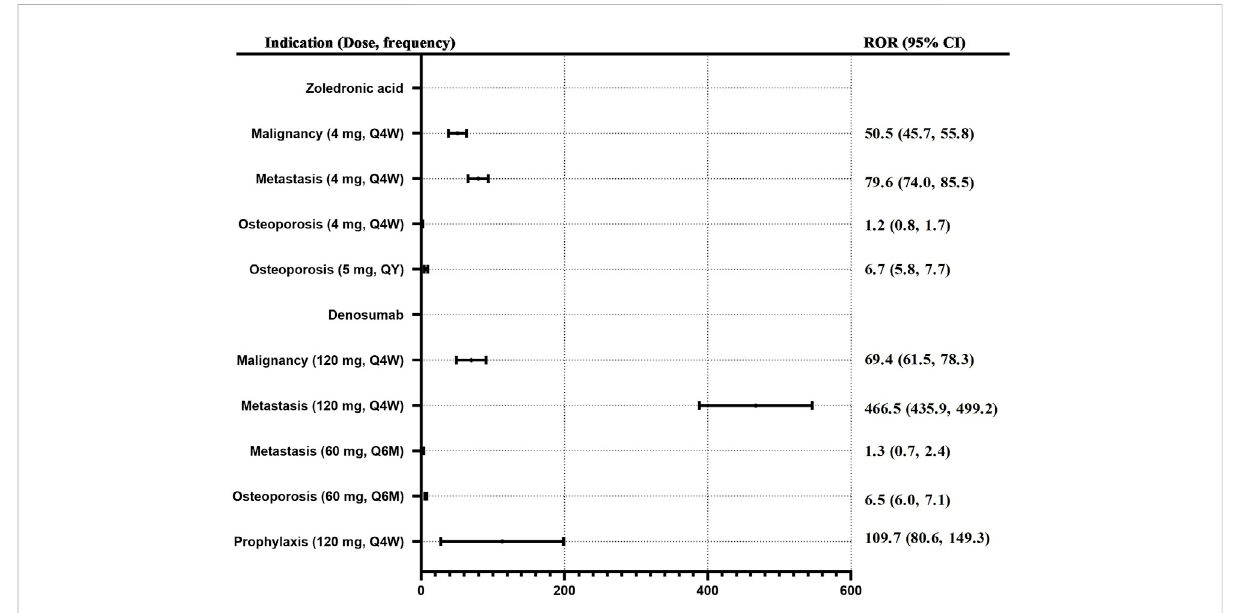
FIGURE 4 ROR for ONJ of denosumaband zoledronic acid with different doses and frequency for different indications. Note:Q4W, every 4 weeks; Q6M, every 6 months, QY, every 1 year.